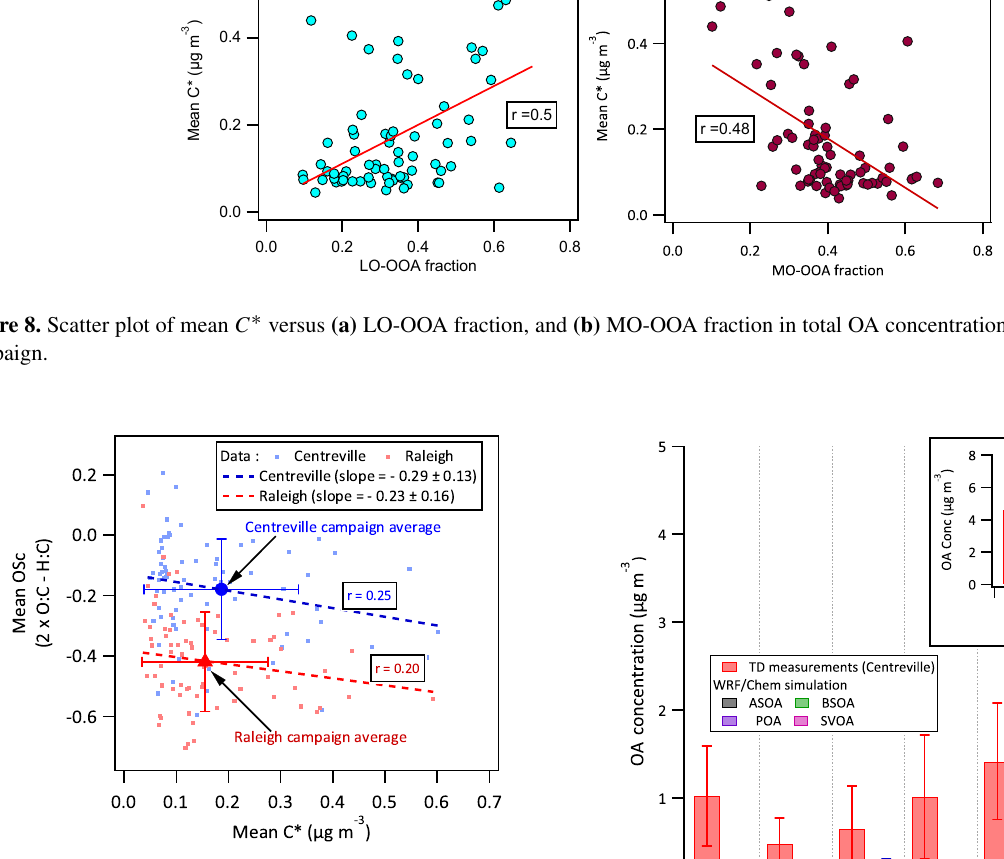
Figure 9. Mean oxidation state ( OS c ) vs. mean volatility (C ∗ ) mea- sured during the Centreville and Raleigh campaigns. Dots are cam- paign data, dashed lines are linear regression fits of data, and sym- bols are the campaign average with error bar showing ± 1 standard deviation.